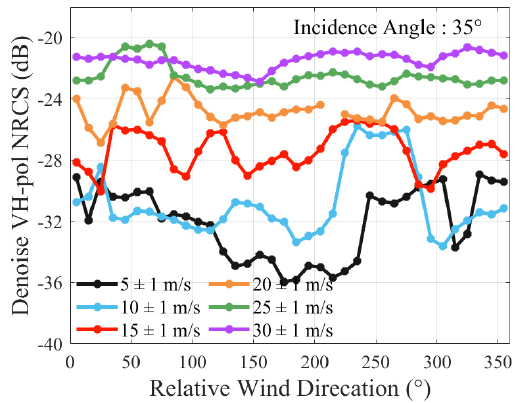
Figure 6. Influence of wind direction on the cross-polarized NRCS for different wind